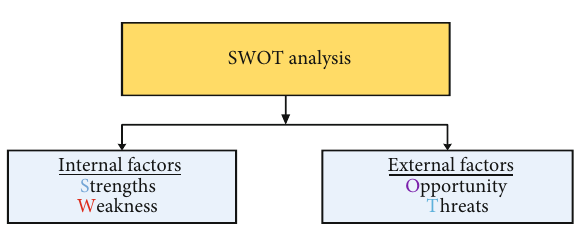
Figure 14: Basic elements of the SWOT analysis